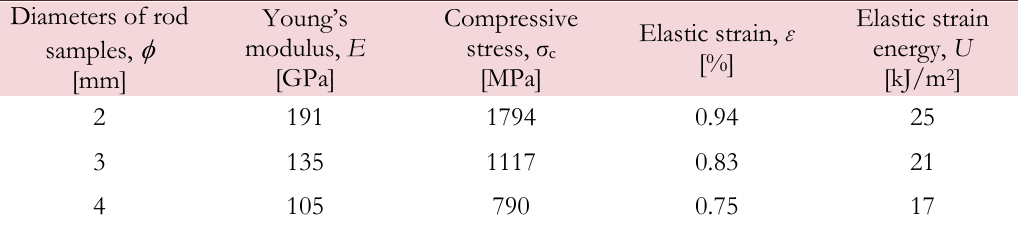
Table 1: Compressive mechanical properties of samples of the Fe 36 Co 36 B 19 Si 5 Nb 4 BMGs rods used in compression test at room temperature.